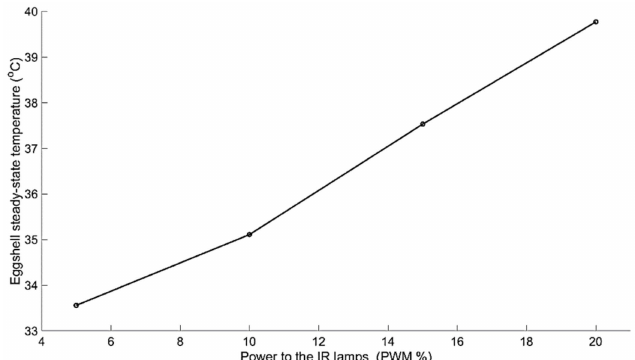
Figure 9. The resulted steady-state temperature of the eggshell at di ff erent PWM (%) to the IR lamps at distance h = 0.15 m.